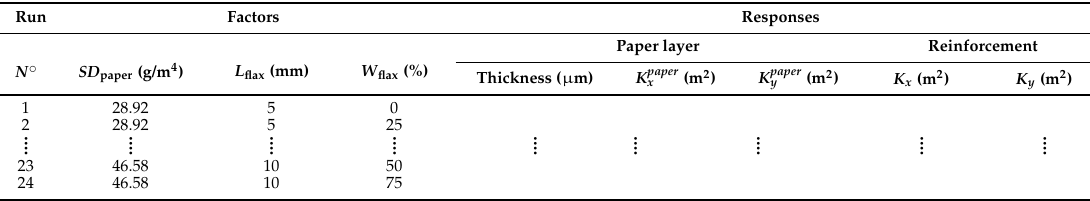
Table 2. Design of experiments for permeability study.